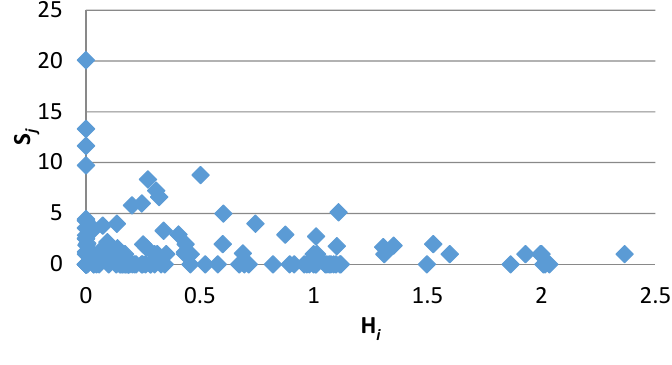
Figure 4. S (cid:3037) versus H (cid:3036) relationship. Figure 4. S j versus H i